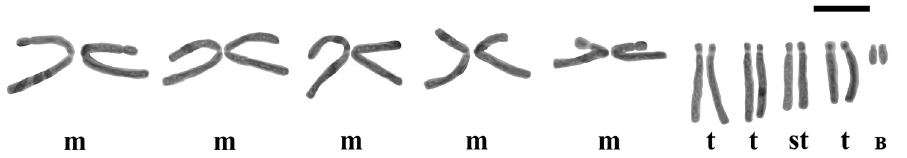
Figure 2. Karyogram of Fritillaria montana from Mt. Vourinos, 2n = 2x = 18. Bar = 10 µm. Table 3. Karyomorphometric indices of marker chromosomes for each species, marker chromosome pairs (numbered according to their chromosome length), long arm’s length (l), short arm’s length (s), chromosome length (l + s) with minimum and maximum prices, r- index, Centromeric index, Arm dif- ference ratio,